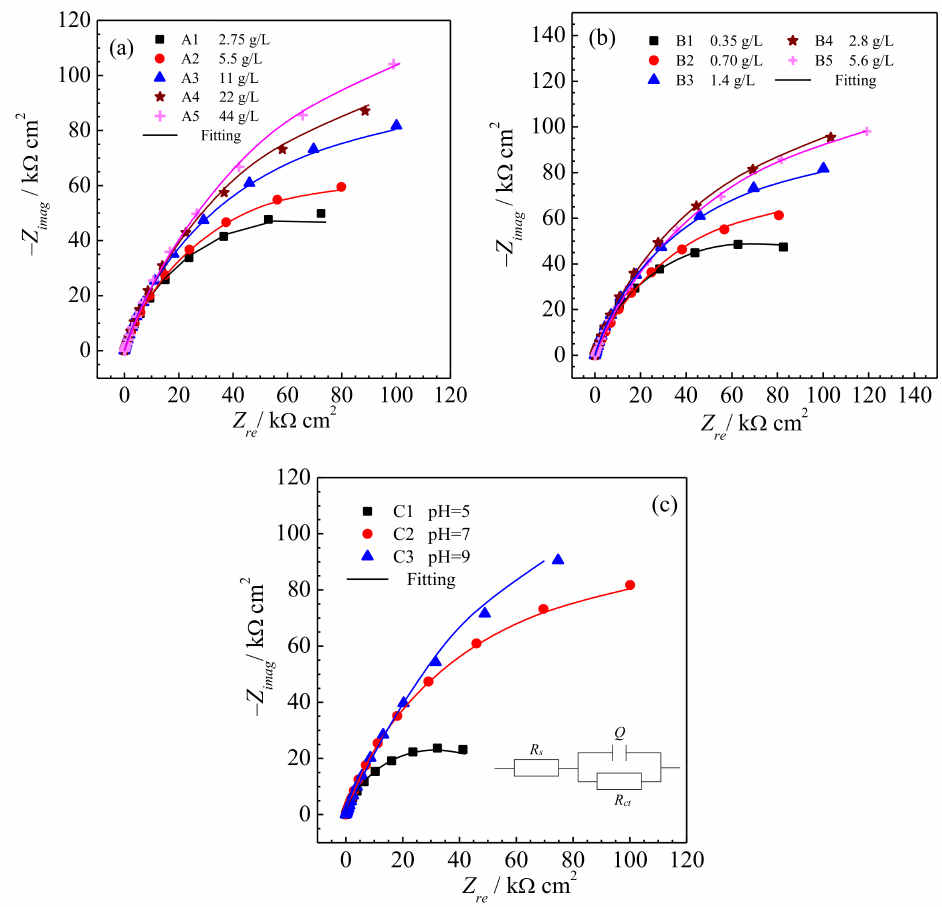
Figure 3. EIS results of the 201 low-nickel stainless steel in the underground water, ( a ) A1–A5 solutions with different concentration of SO 42 − , ( b ) B1–B5 solutions with different concentration of HCO 3 − , and ( c ) C1–C3 solutions with different pH